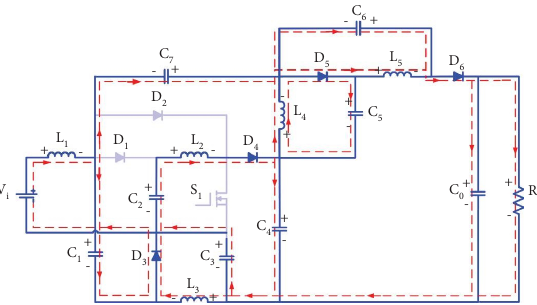
Figure 3: Equivalent circuit of proposed converter in mode II (frst stage).